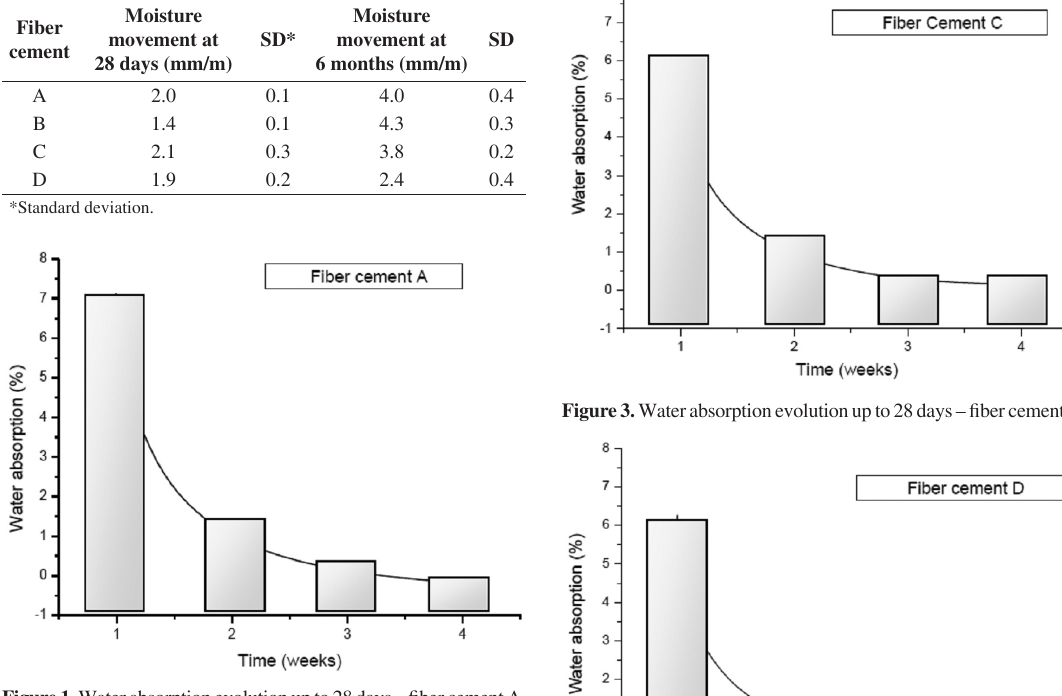
Figure 1. Water absorption evolution up to 28 days – fiber cement A.